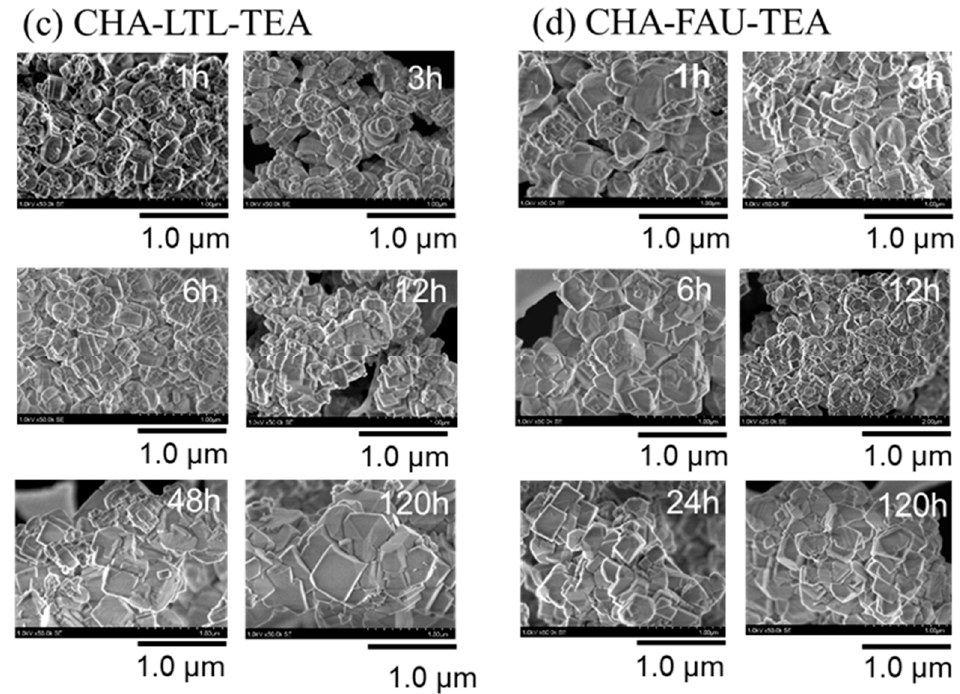
Figure 6. SEM images of ( a ) CHA–LTL–TMAda, ( b ) CHA–FAU–TMAda, ( c ) CHA–LTL–TEA, ( d ) CHA–FAU–TEA at different crystallization times.